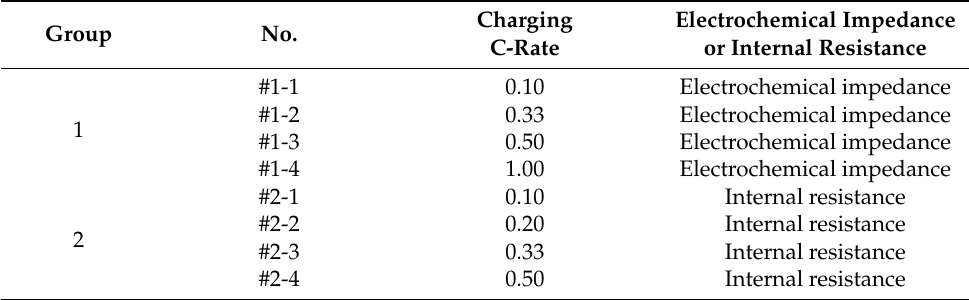
Table 2. Detailed setup of the